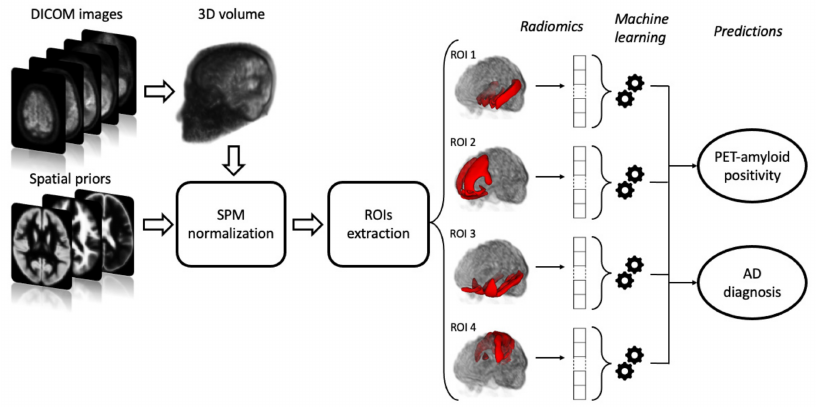
Figure 1. The proposed radiomics workflow, from SPM-based image pre-processing to Pyradiomics -based feature extraction process to machine learning-based